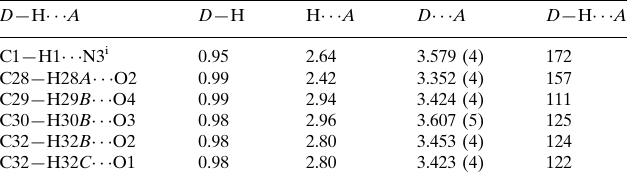
Data collection Rigaku Mercury diffractometer Absorption correction: multi-scan (Jacobson, 1998) T min = 0.799, T max = 0.921